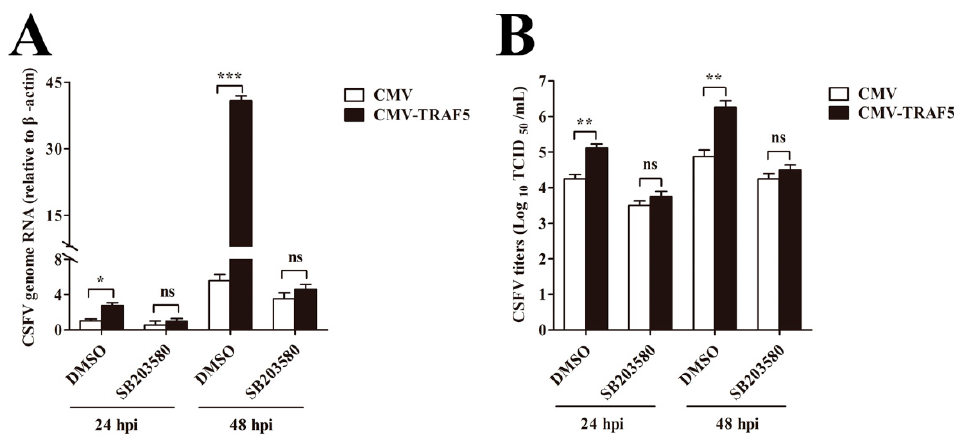
Figure 7. TRAF5 overexpression does not promote CSFV replication following inhibition of p38 MAPK activation in PAMs. ( A , B ) CSFV replication in SB203580-treated CMV-TRAF5 cells. CMV and CMV-TRAF5 cells were treated with SB203580 for 1 h, followed by CSFV infection. The cell lysates and at 24 and 48 hpi, respectively. The data represent the mean ± SD of three independent